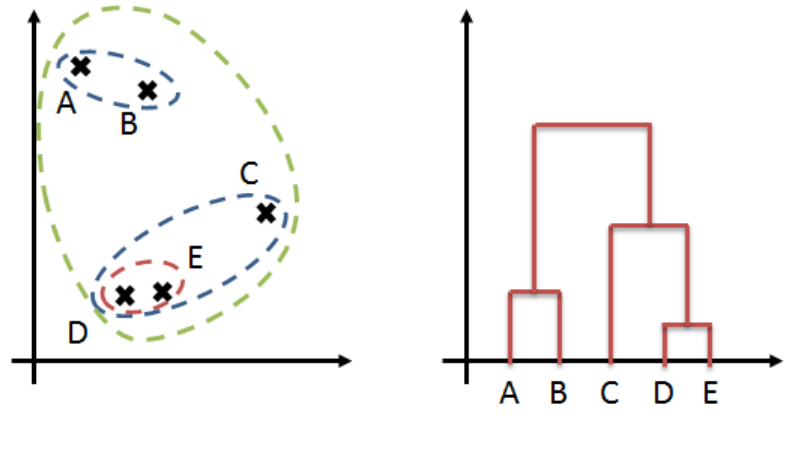
Figure 4. Cluster analysis example. The left panel represents a population of five individuals ( A to E ) with the successive clusters. The right panel represents the corresponding